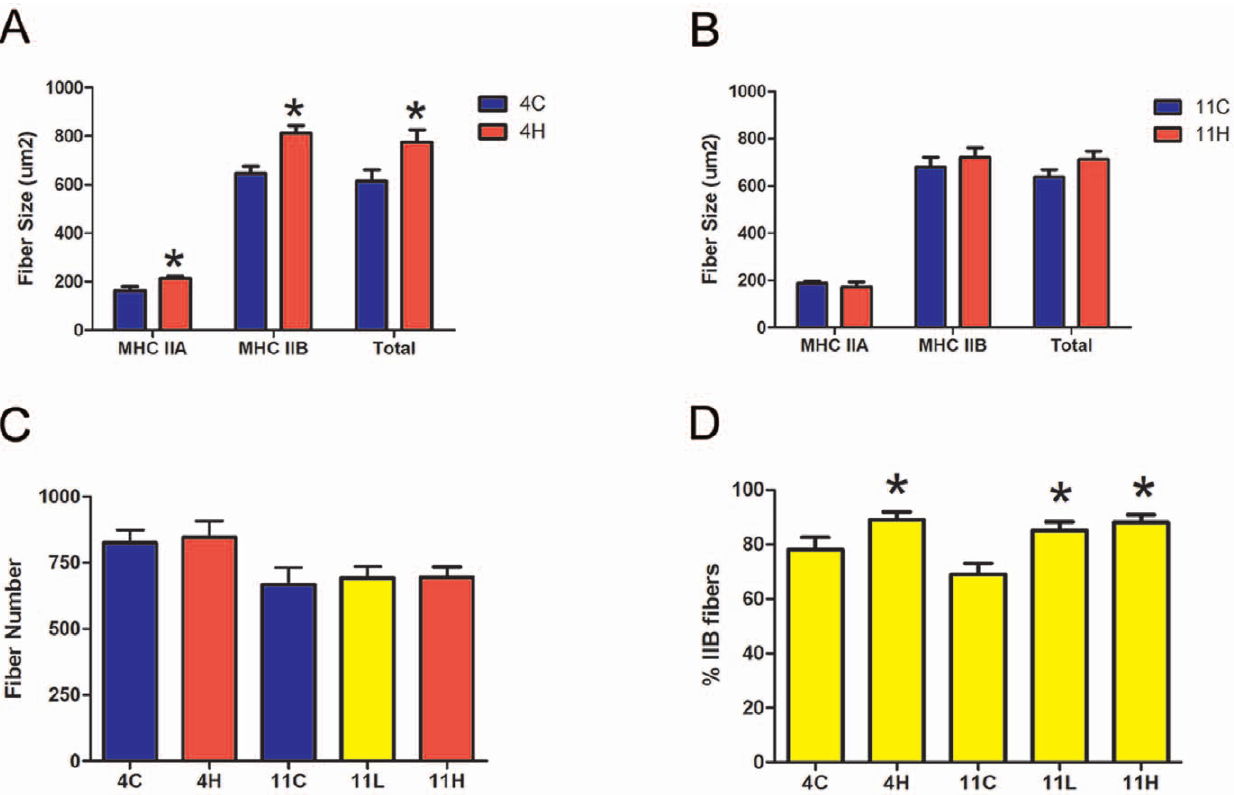
Figure 5. Morphological analysis of the mdx EDL. (a) In the mdx 4H group, the mean fiber size of myosin heavy chain (MHC) type IIA and IIB fibers increased which led to an overall increase in total fiber size. (b) At eleven months of age, the mdx 11H group did not demonstrate fiber size differences of either fiber type or total fibers compared to controls. (c) The number of fibers in the midbelly cross section of the EDL in all treated groups was not different from respective control fiber number. (d) There were 11% more type IIB fibers in the mdx 4H group while in the mdx 11L and 11H groups there were 16–19% more type IIB fibers. Data represent mean 6 SD. * Statistically significant compared to control, p , 0.05.